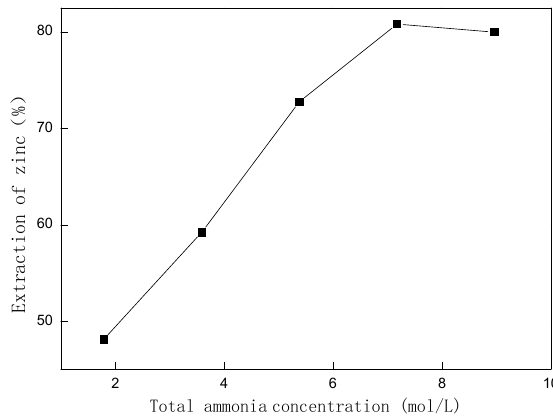
Figure 7. Effect of total ammonia concentration (ammonia/ammonium chloride = 1/2). Time 30 min, L/S 6mL/g, temperature 40 °C.